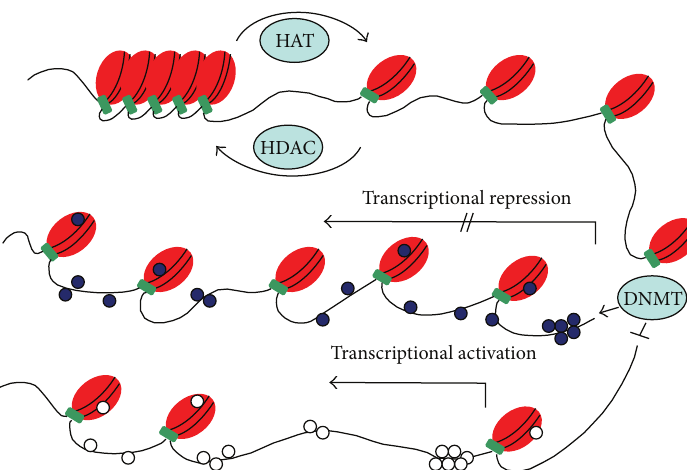
Figure 1: Overview of different epigenetic mechanisms involved in the regulation of chromatin (heterochromatin and euchromatin). Histone acetylation catalyzed by histone acetylase (HAT) that slightly unwraps the DNA from histones and promotes gene expression. Histone deacetylation is catalyzed by histone deacetylase (HADC), which tightens the DNA and histone core together and represses transcription. CpG islands are mostly located in the regulatory regions of genome. DNA methyltransferase (DNMT) adds methyl group to the CpG site, which is the main epigenetic mechanism reported for transcriptional